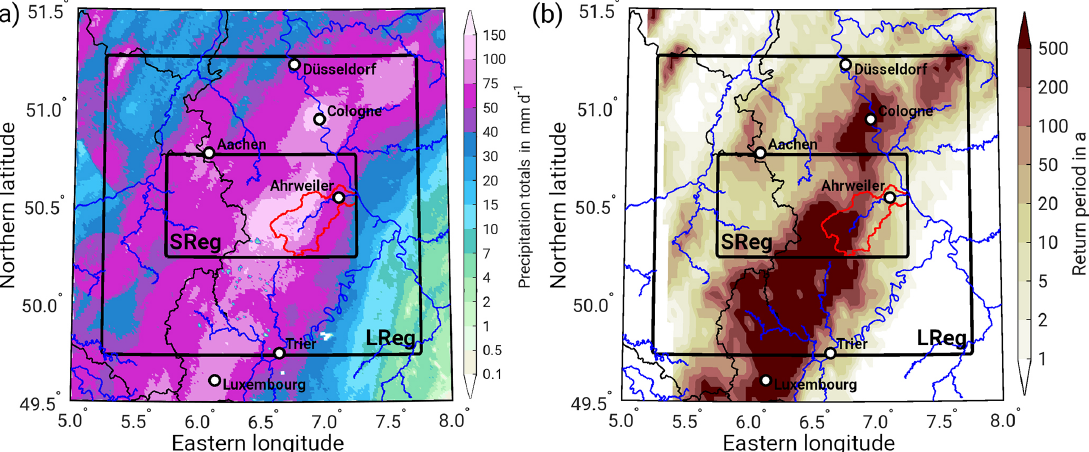
Figure 3. Event characteristics with (a) 24h precipitation totals based on RADOLAN data (14 July 05:50UTC to 15 July 2021 05:50UTC), and (b) statistical return periods of (a) . Note that the RADOLAN data have been remapped to the 5km HYRAS grid in (b) as the climato- logical values are taken from HYRAS (reference period: 1951 to 2015). The black rectangles indicate the regions named LReg and SReg; the red contour outlines the Ahr catchment; the main rivers are given by